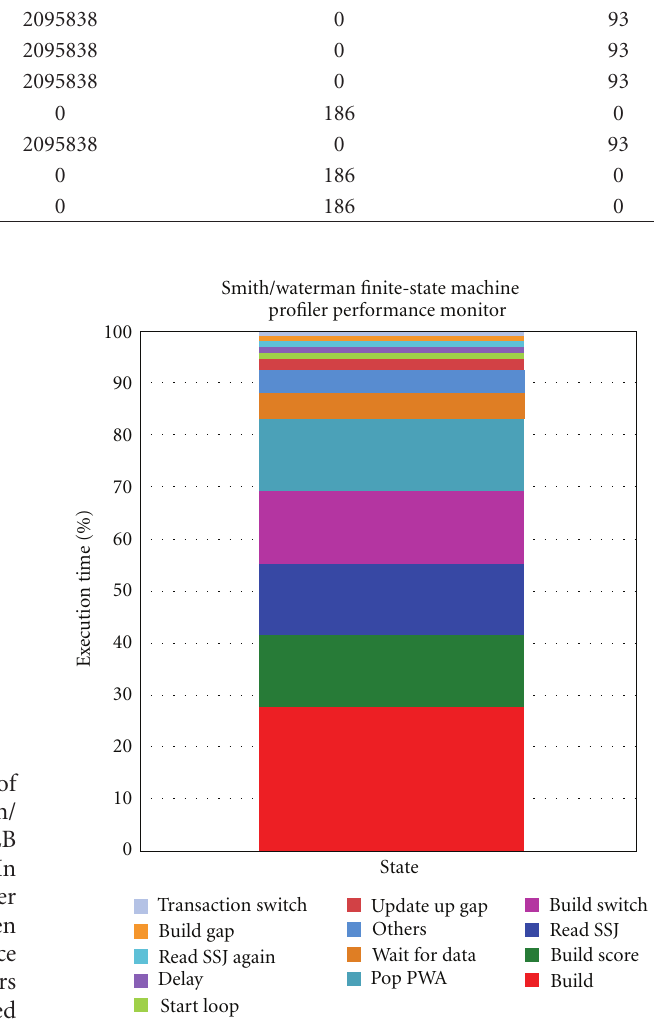
Figure 12: Smith/Waterman core’s FSM profiler monitor